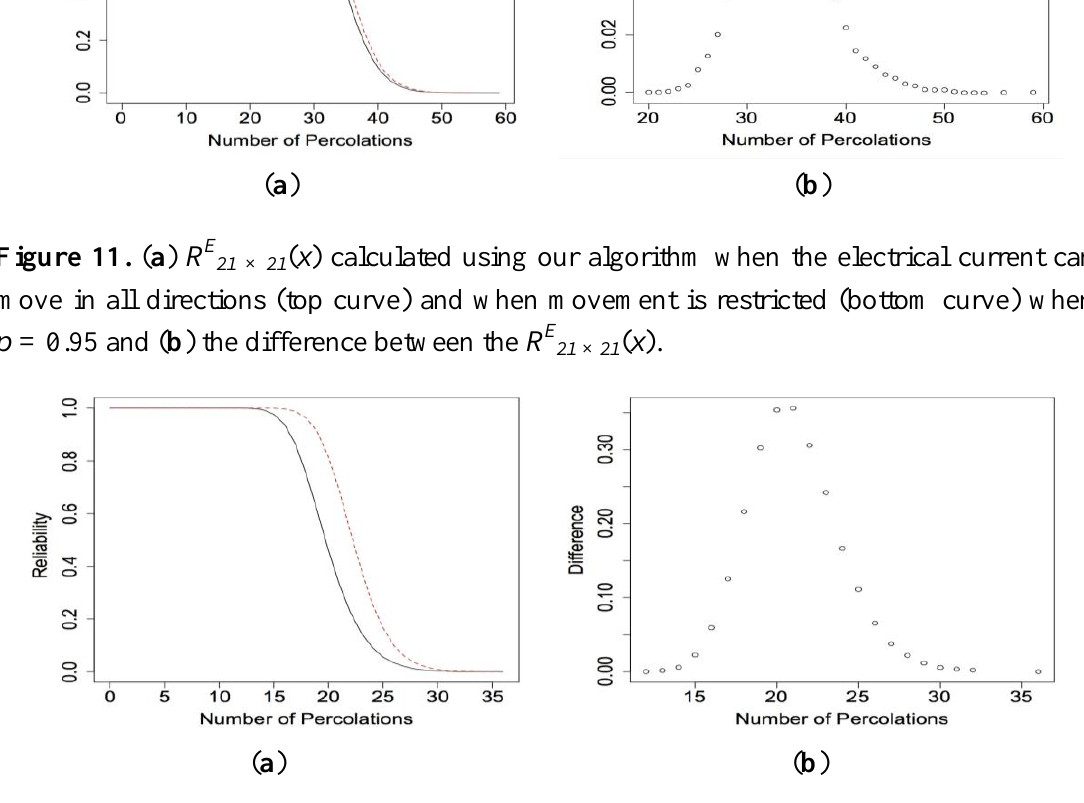
Figure 12. ( a ) R H ( x ) calculated using our algorithm when the electrical current can 9 × 9 move in all directions (top curve) and when movement is restricted (bottom curve) when p = 0.90 and ( b ) the difference between the R H ( x 9 × 9